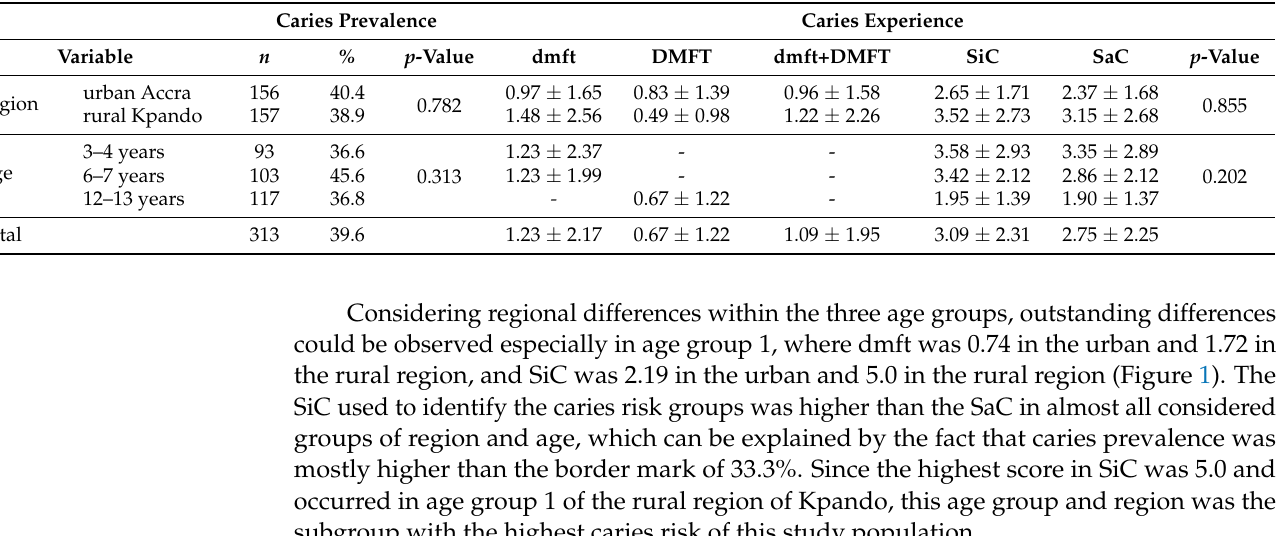
dmft or DMFT in Accra